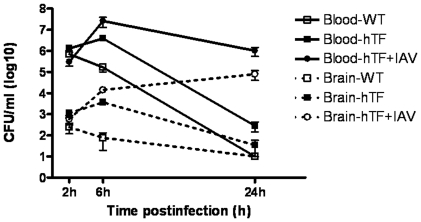
Blood and brain bacterial counts after intraperitoneal challenge.Congenic mice (wild-type, human transferrin expressing transgenic mice with or without IAV infection) were challenged by intraperitoneal injection of 5*106 CFU of the N. meningitidis serogroup C strain LNP24198. At each indicated time point, mice were anaesthetized, blood samples were withdrawn and then perfusion was performed for each mouse to wash out blood using phosphate saline buffer. Brains were then extracted. Blood and brain samples were plated to determine the bacterial counts in each fraction. Data represent the means ± SD from 5 independent experiments of groups of five mice per time point in each experiment.